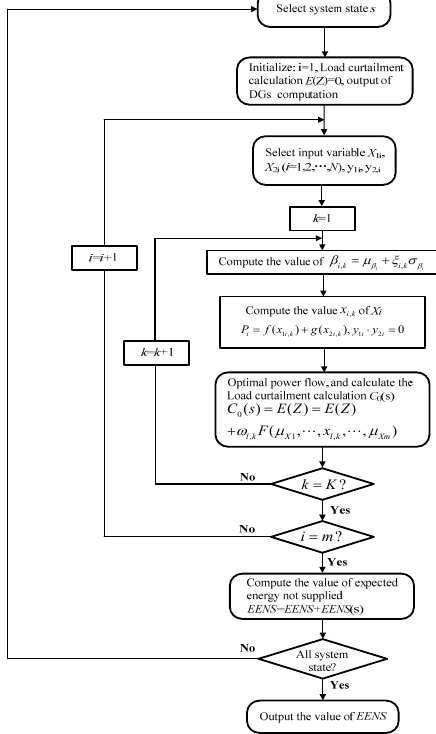
Figure 2. Flow chart of computing procedure for expected energy not supplied (EENS).